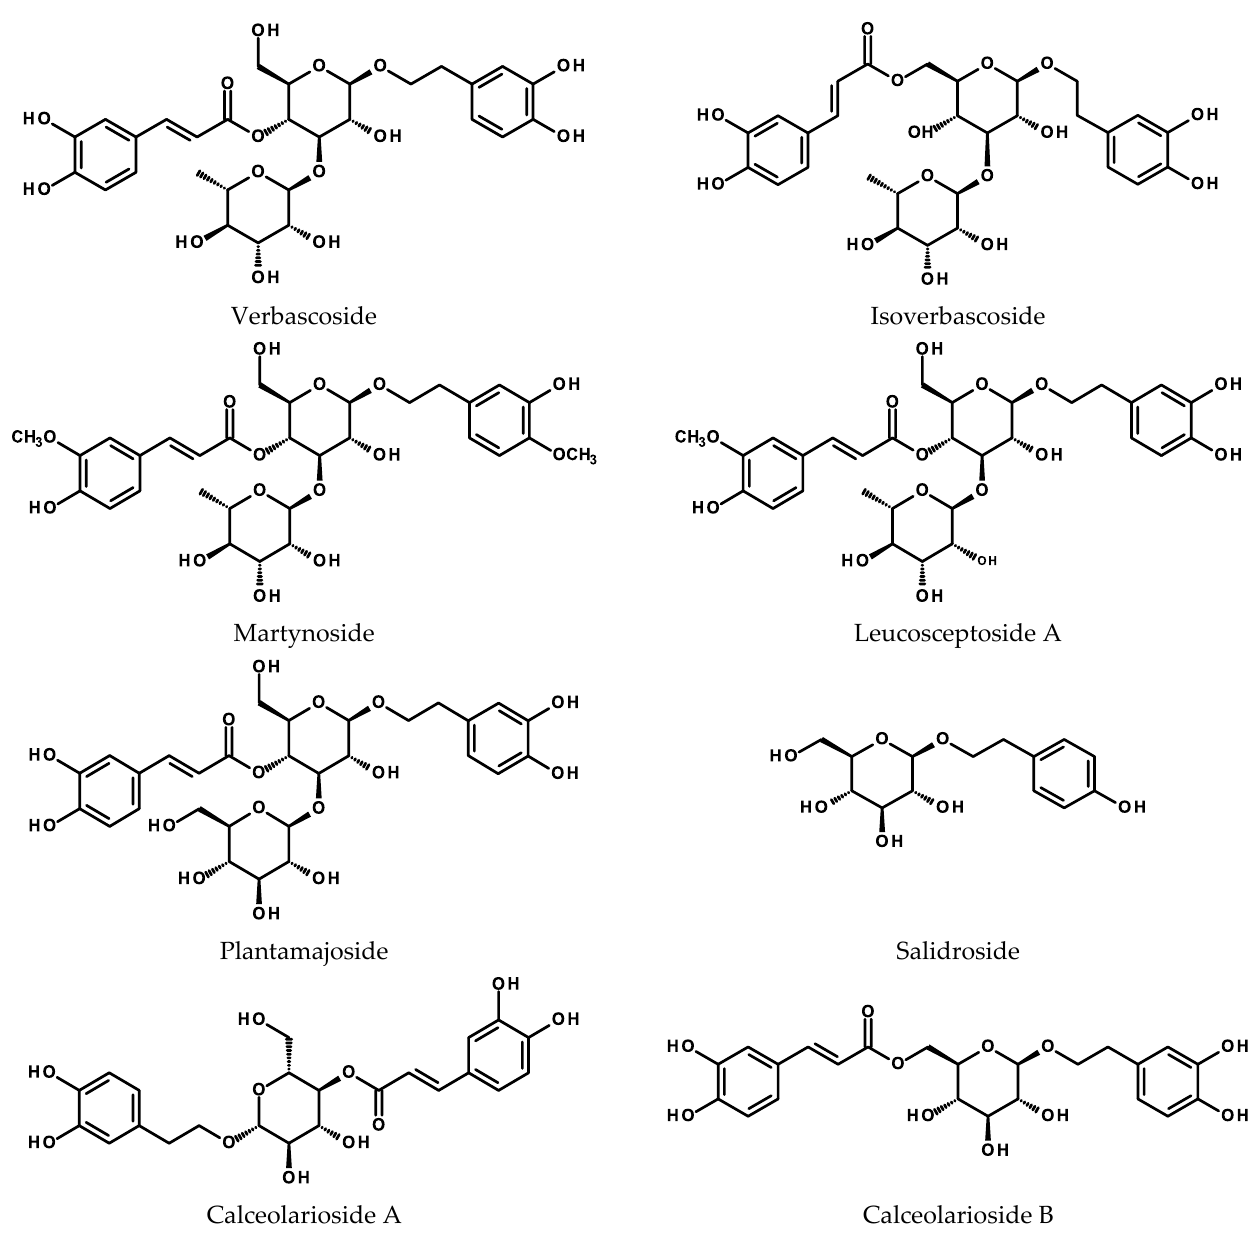
Figure 2. Chemical structures of selected phenylethanoids.